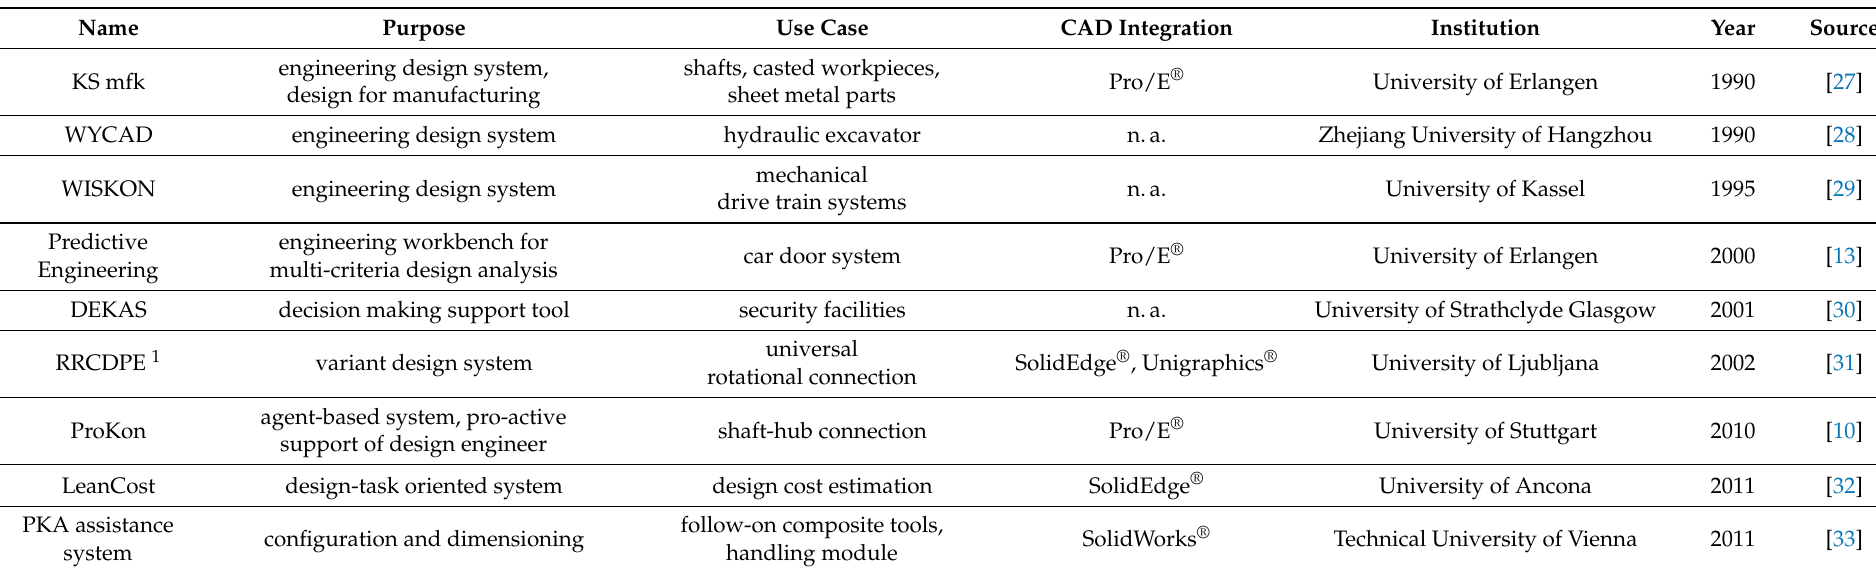
Table 1. Collection of examples for knowledge-based systems within the domain of engineering